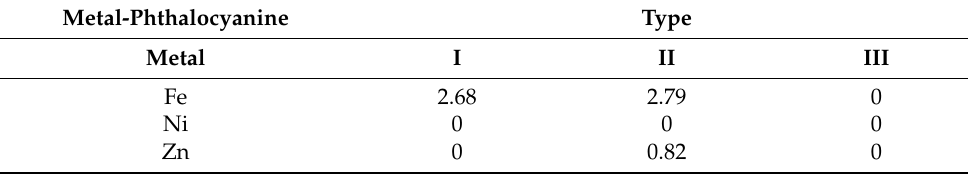
Table 10. Computed dipole moment